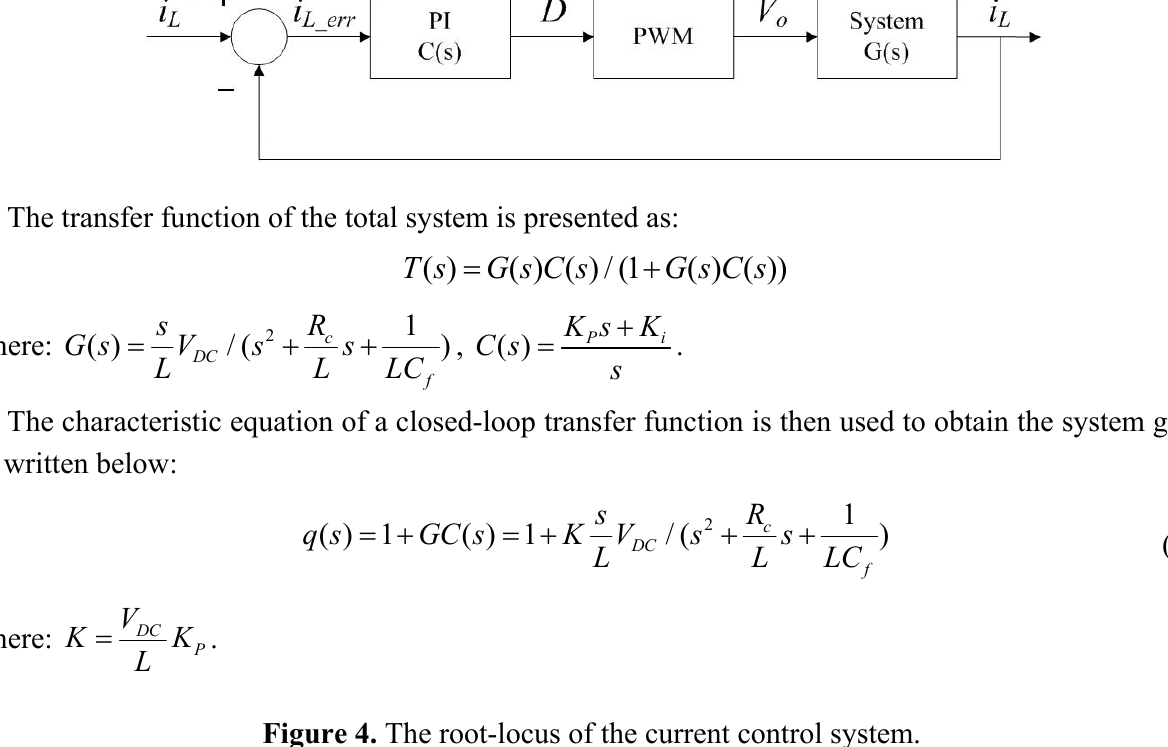
Figure 4. The root-locus of the current control